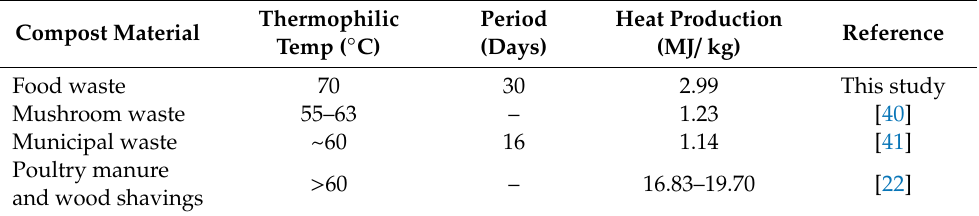
Table 3. Comparison of heat production values during the composting process.